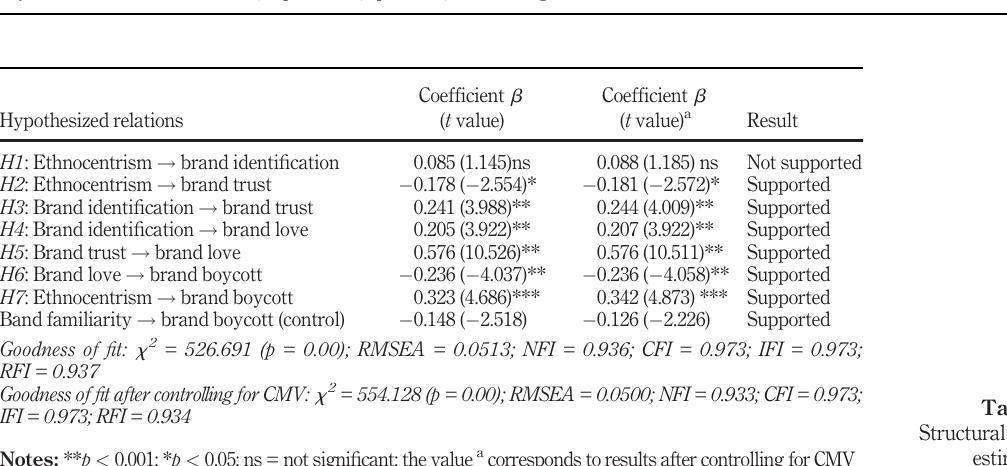
Table 4. Structural model